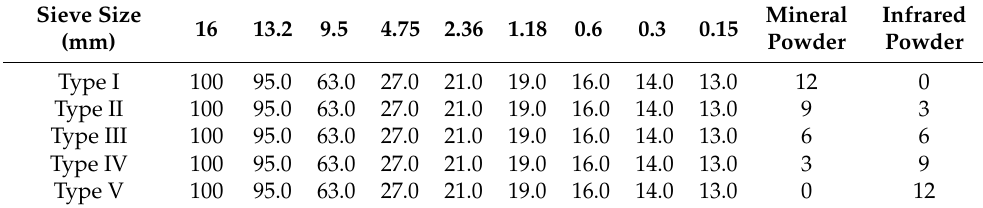
Table 5. Aggregate gradation (passing percent